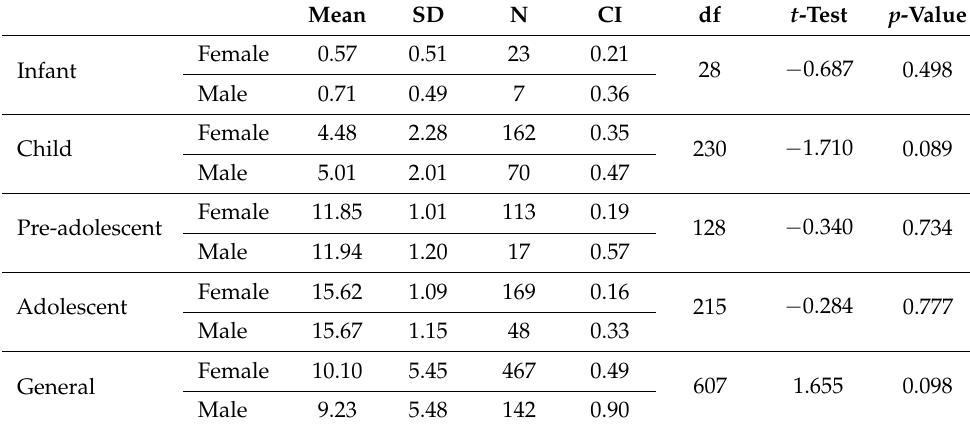
Table 3. Comparison of victim’s gender to age.